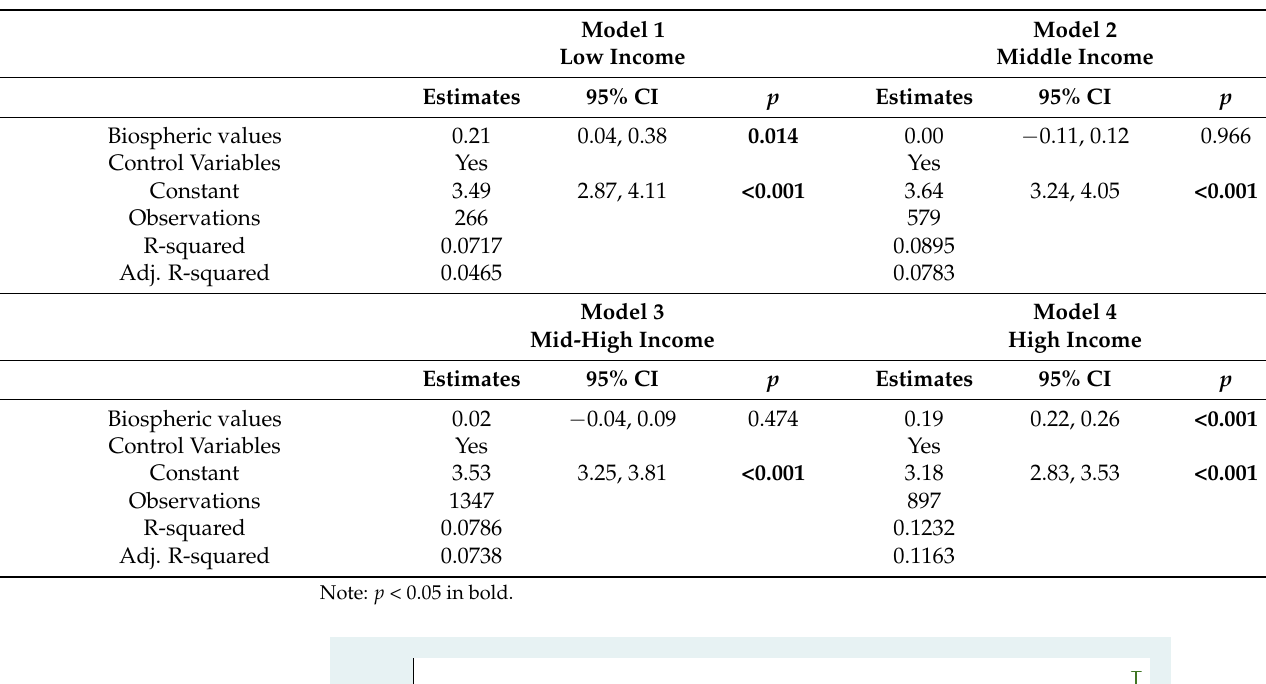
Table 11. Heterogeneous effect of income in the relationship of biospheric values and attitudes.